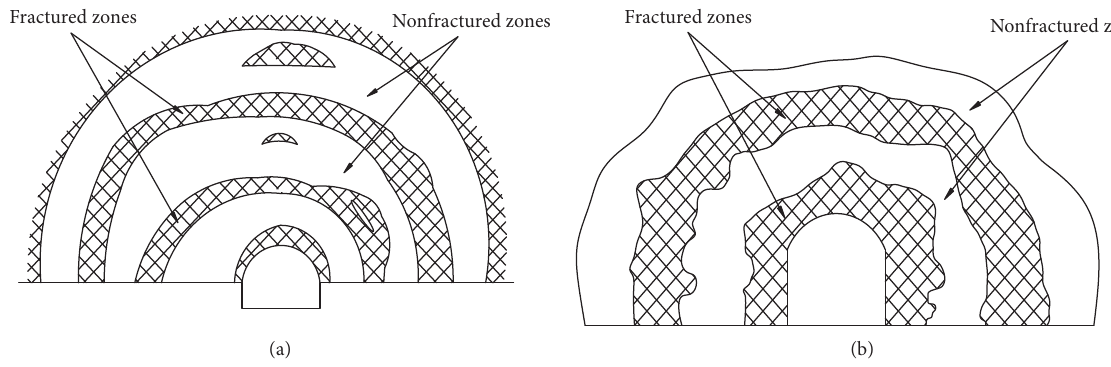
Figure 1: Measurement results of zonal disintegration in tunnels in deep mines: (a) zonal disintegration phenomenon in Russia ʼ s Na>l mine; (b) zonal disintegration phenomenon in Chinese Jinchuan nickel mine.